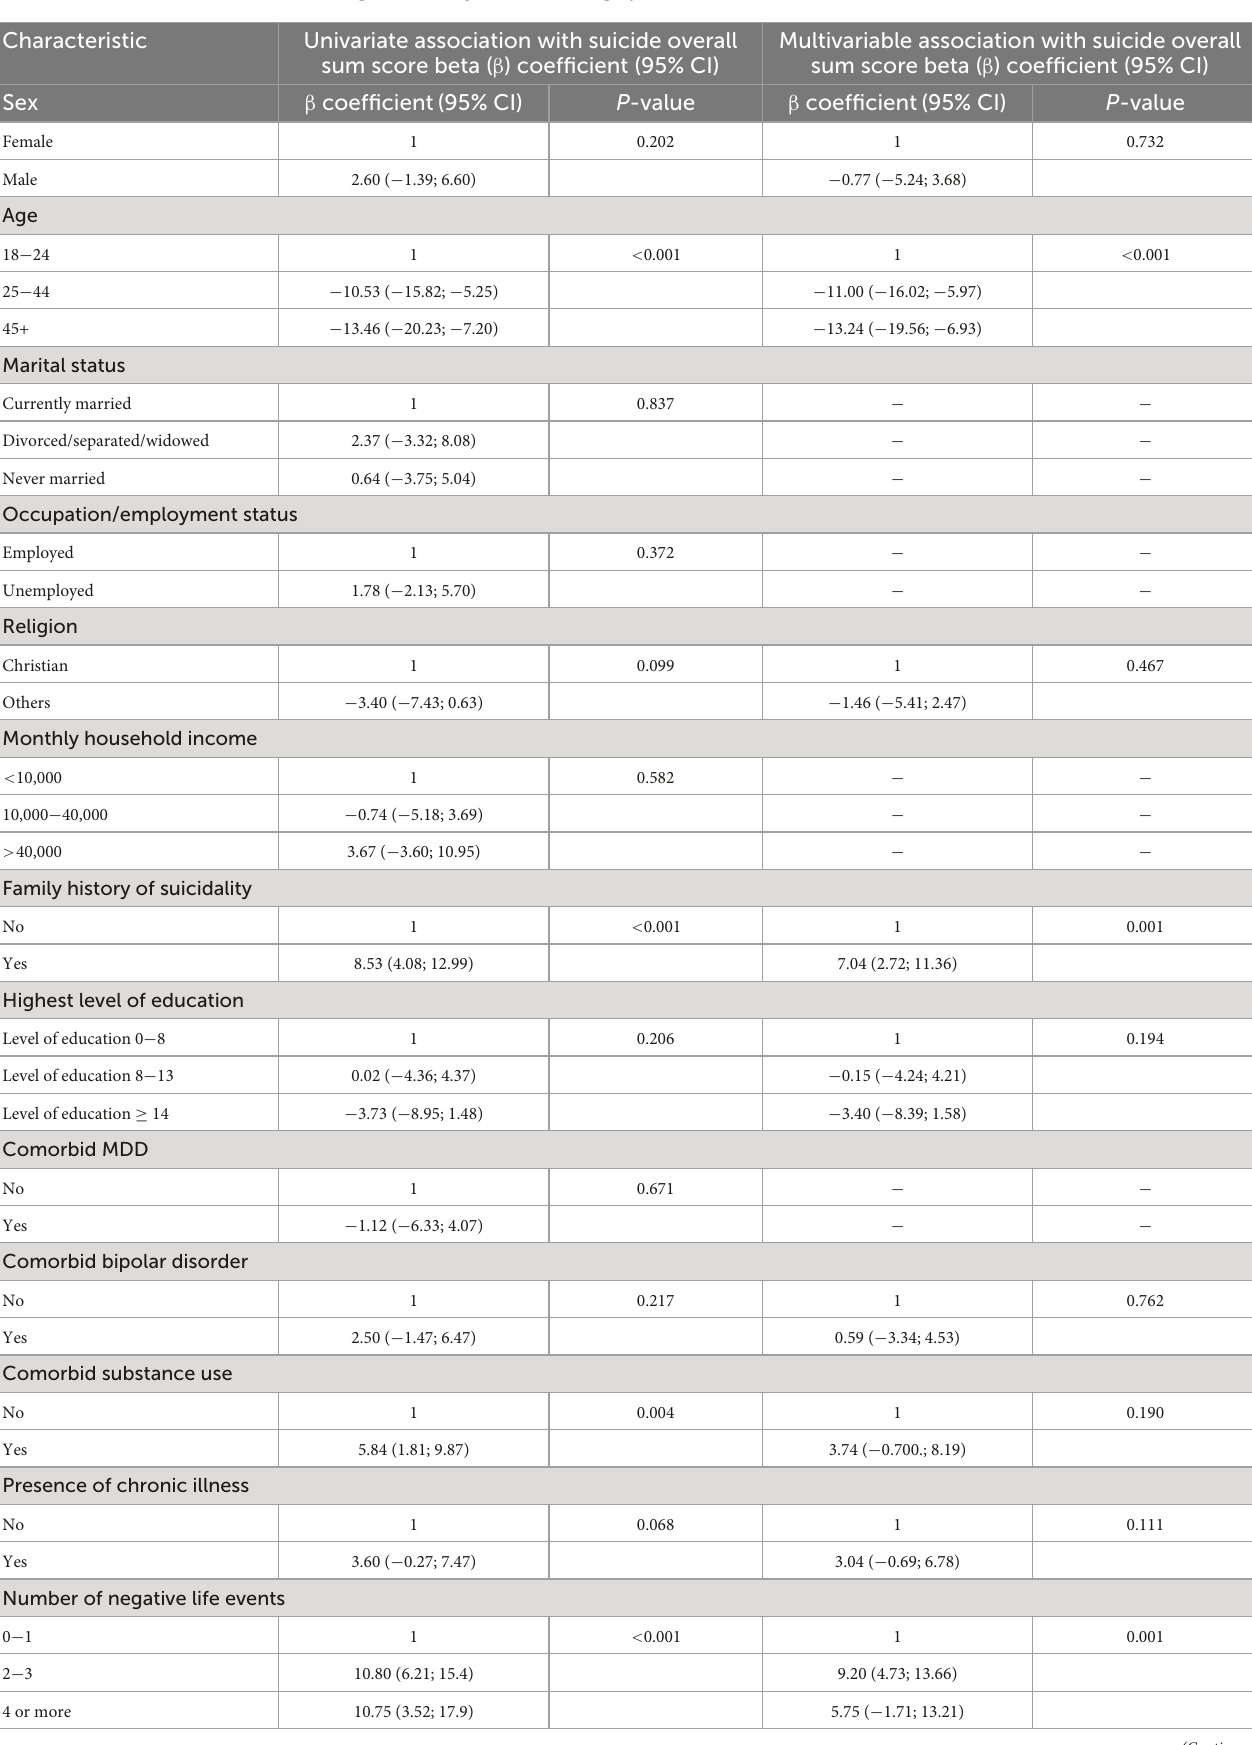
TABLE 5 Univariate and multivariate linear regression analyses: Sociodemographic and clinical factors associated with an overall suicide risk score, N = 615.